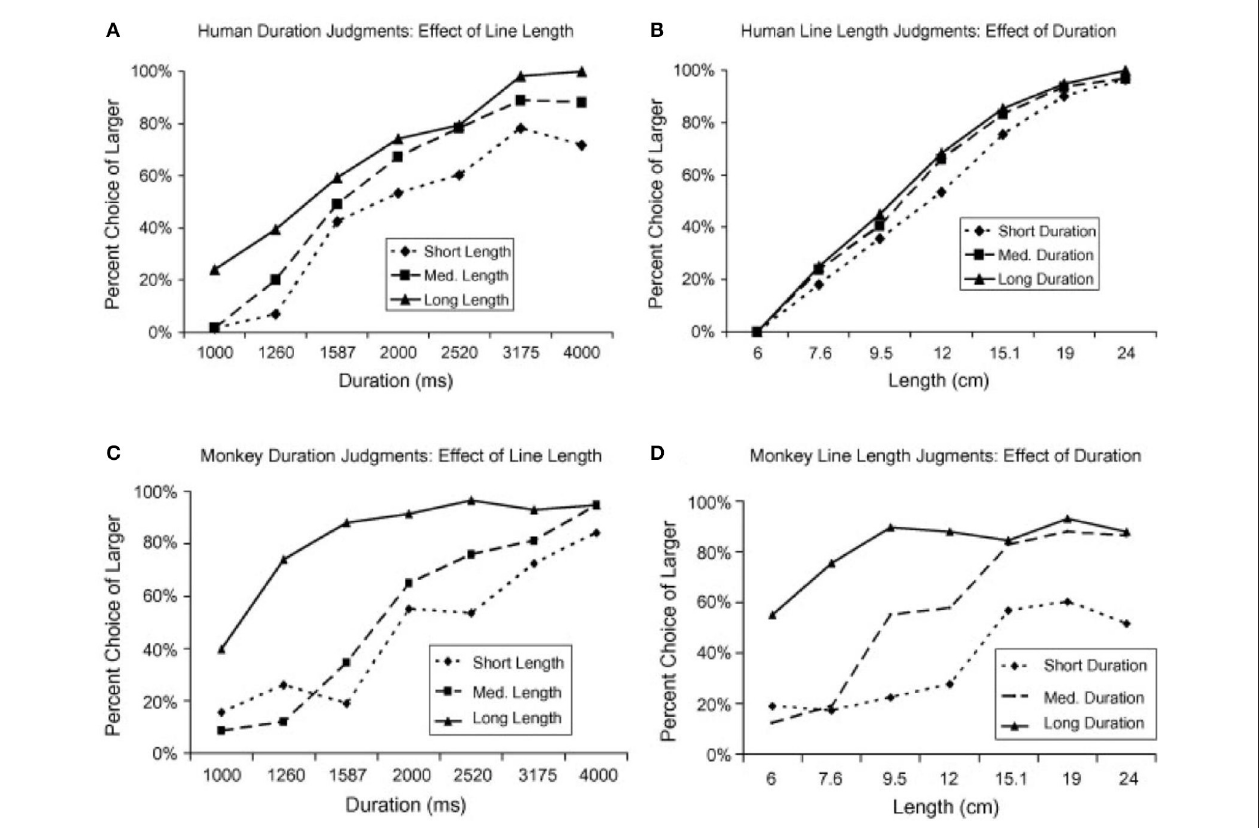
FIGURE 1 | Humans and monkeys judgements of duration and line length (adapted from Merritt et al., 2010). (A) Humans estimations of stimulus duration (relevant variable) when crossed with three different values of line length (irrelevant variable): short (6 cm), medium (12 cm), and long (24 cm). (B) Humans estimations of line length (relevant variable) when crossed with three different values of duration (irrelevant variable): short (1,000ms), medium (2,000ms), and long (4,000ms). (C) Same as in (A) but for monkeys estimations of duration. (D) Same as in (B) but for monkeys estimations of line